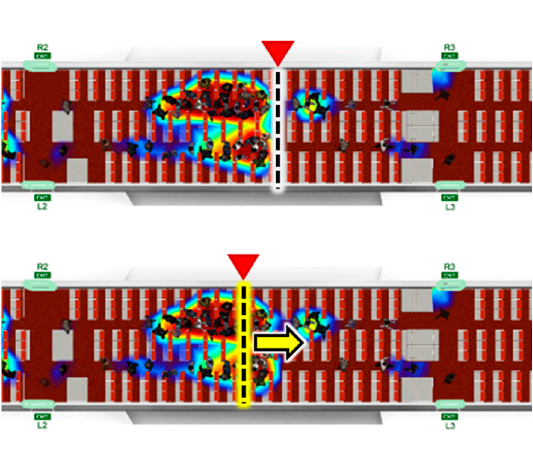
Figure 4. How to adjust seat row by analyzing density of the passengers.